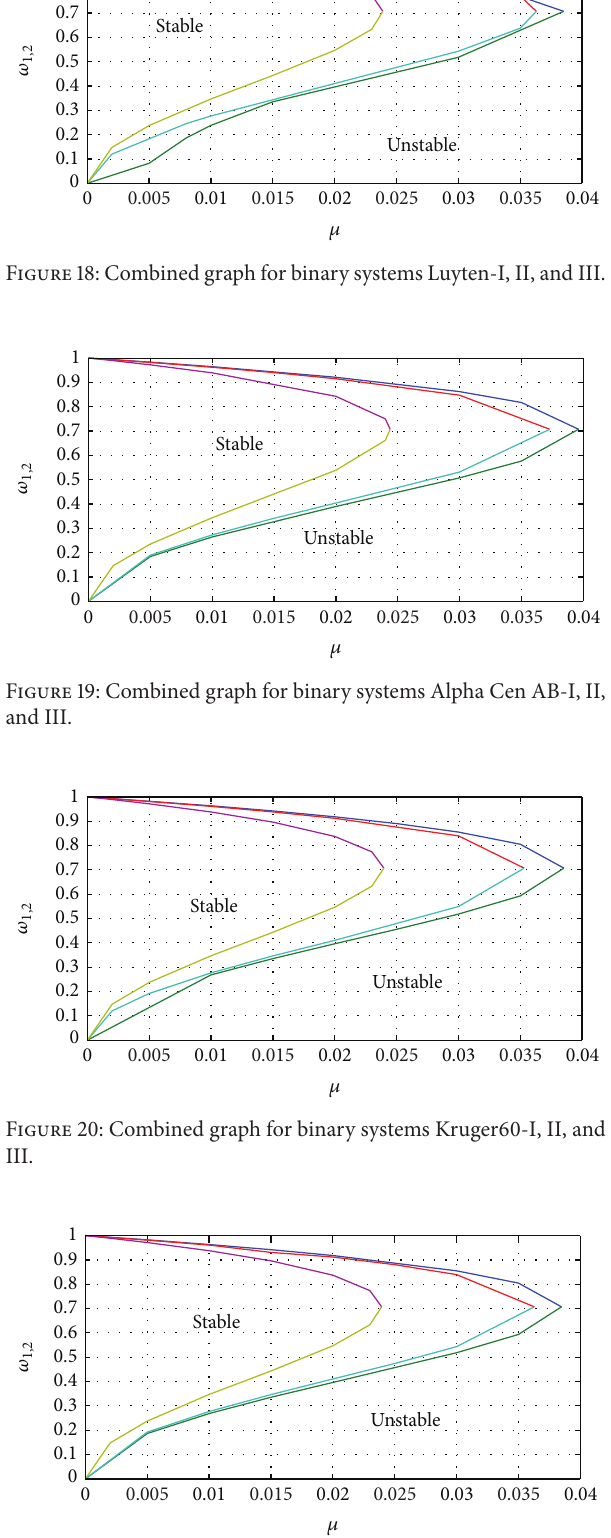
Figure 21: Combined graph for binary systems Xi-Booties-I, II, and